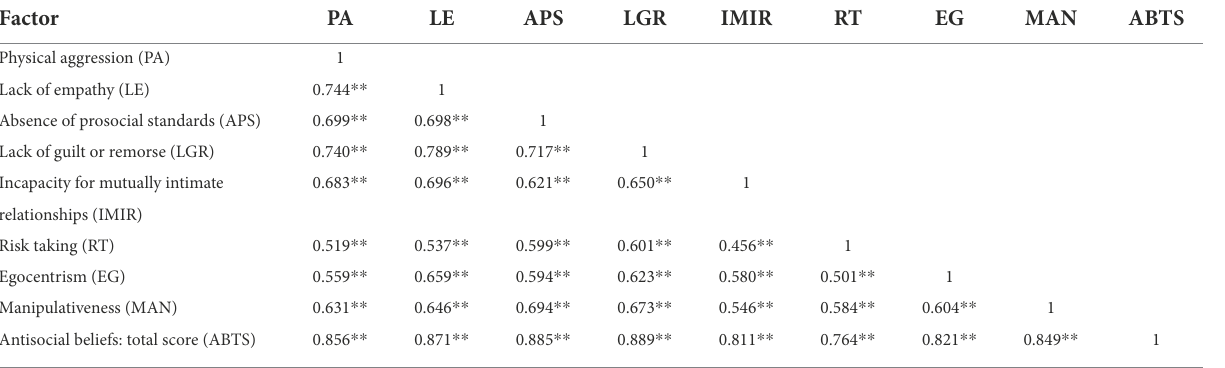
TABLE 7 Correlations between ABS factors.